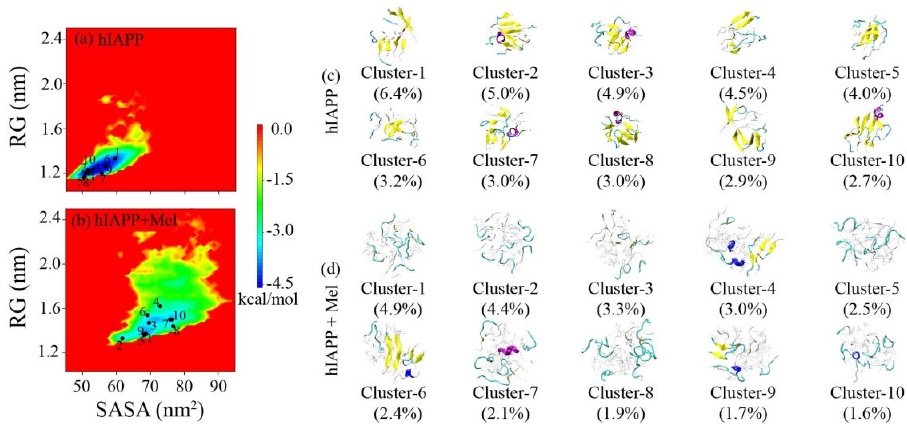
Figure 4. ( a , b ) Potential mean force (PMF) (in kcal/mol) as a function of SASA and RG of the hIAPP 20–29 octamer and hIAPP 20–29 + Mel systems in the absence and presence of Mel. ( c , d ) Repre ‐ sentative conformations of the first ten most ‐ populated clusters in the hIAPP 20–29 and hIAPP 20–29 + Mel systems. The corresponding percentage is given in